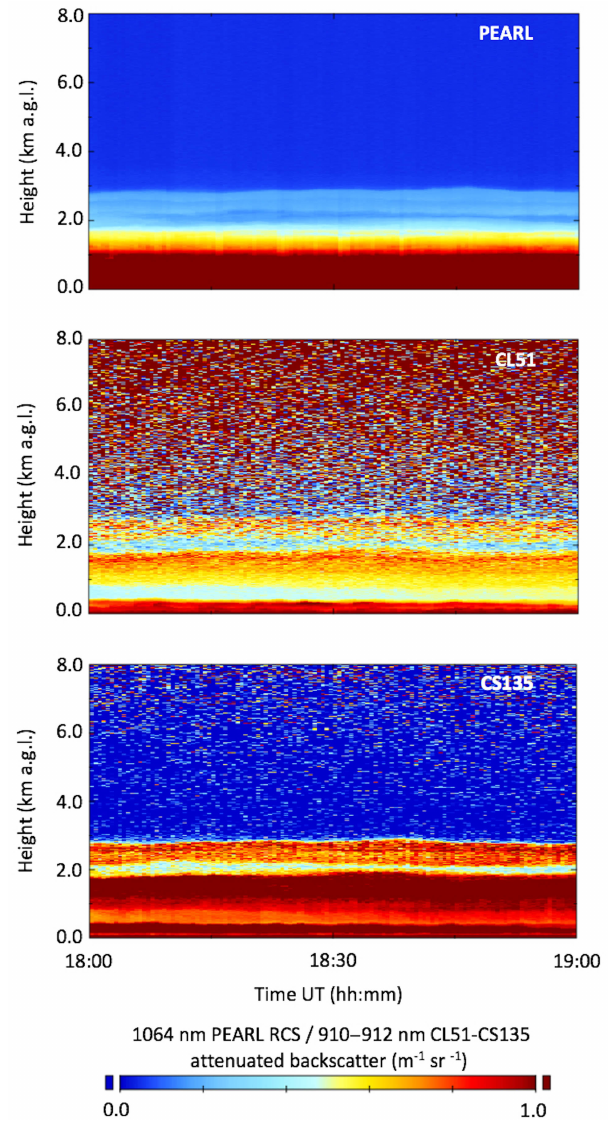
Figure 2. Time series of 1064nm PEARL RCS and 910–912nm CL51 and CS135 attenuated backscatter profiles as provided by the manufacturer software for the measurements collected on 13 Octo- ber 2016 from 18:00 to 19:00UT; heights are above ground level (a.g.l.); raw time and vertical resolutions are 1min and 7.5m for PEARL, 30s and 10m for CL51 and 30s and 5m for